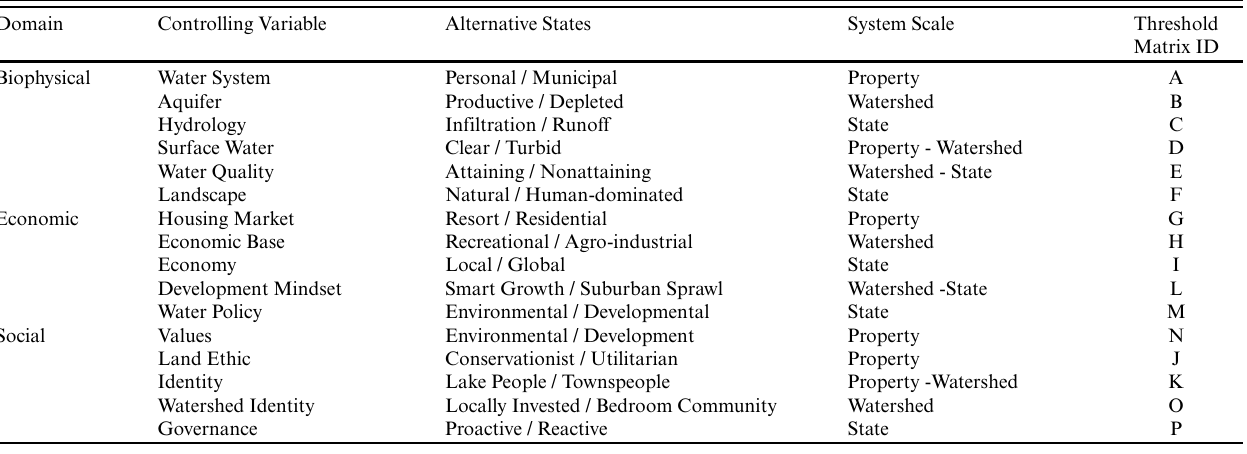
Table 1 . Controlling variables and their potential alternative stable states. Controlling variables are organized by the domain in which they occur.